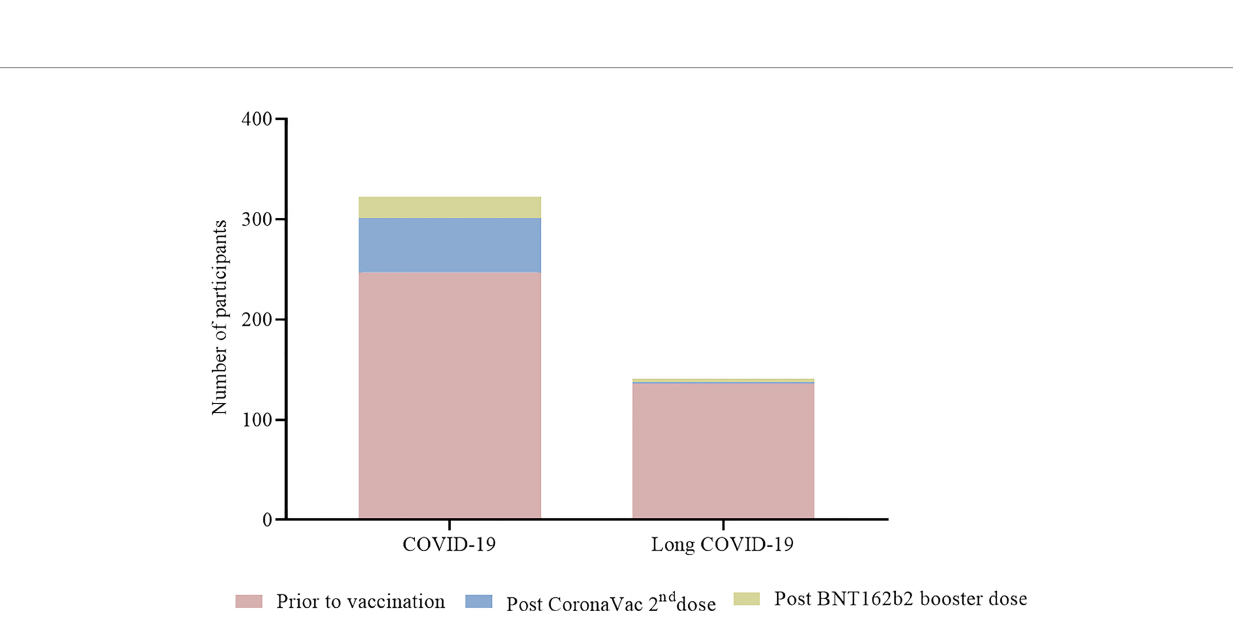
FIGURE 8 | Participants with COVID-19 and long COVID before and after vaccination. Numbers of participants are presented in each column for participants before vaccination ( ), vaccinated with two doses of CoronaVac only ( ) and vaccinated with two doses of CoronaVac + BNT162b2 booster dose ( ).